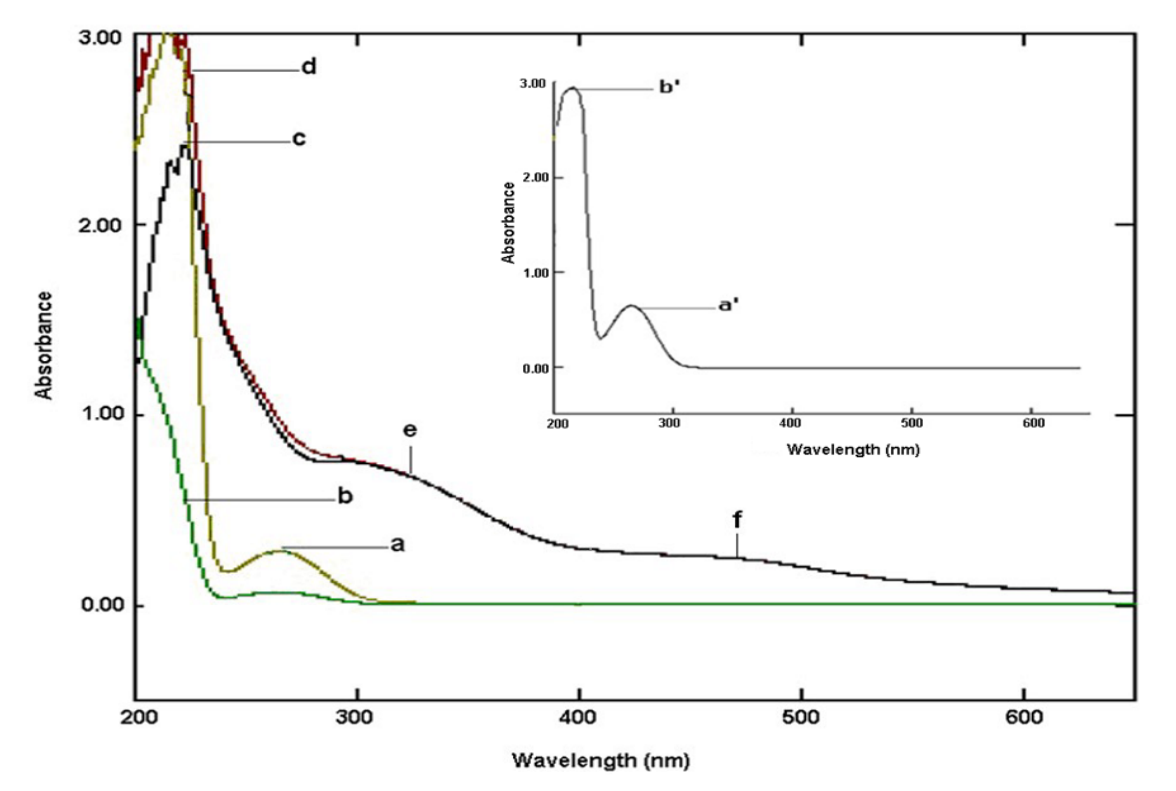
Figure 3. UV-Vis absorption spectrum of carnosine (0.88 mM a’ , b’ ) and (0.42 mM a , b ) and its ruthenium complex ( c , d , e and f